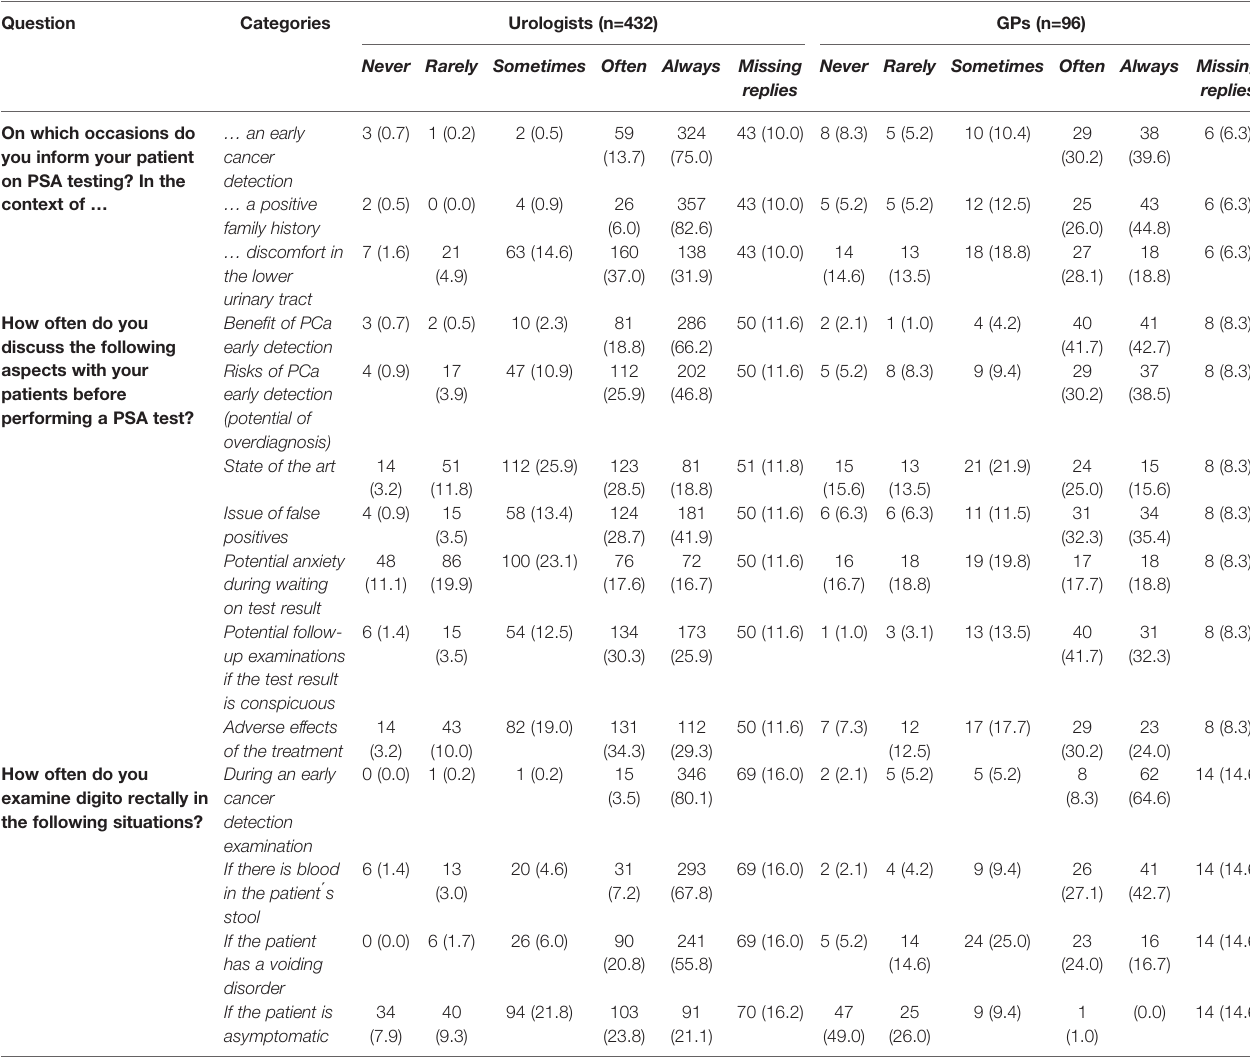
TABLE 6 | Information communication of prostate-speci fi c antigen testing by urologists and general practitioners [n